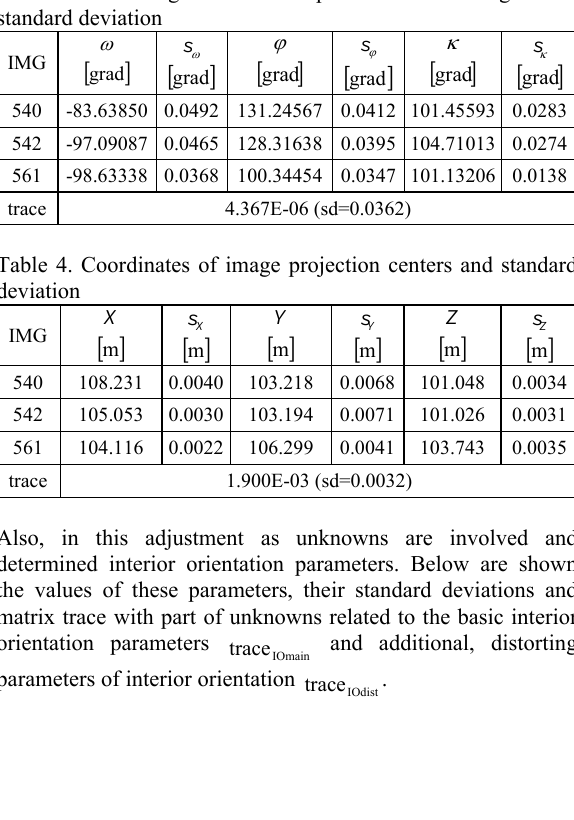
Table 3. The angular exterior parameters of images and